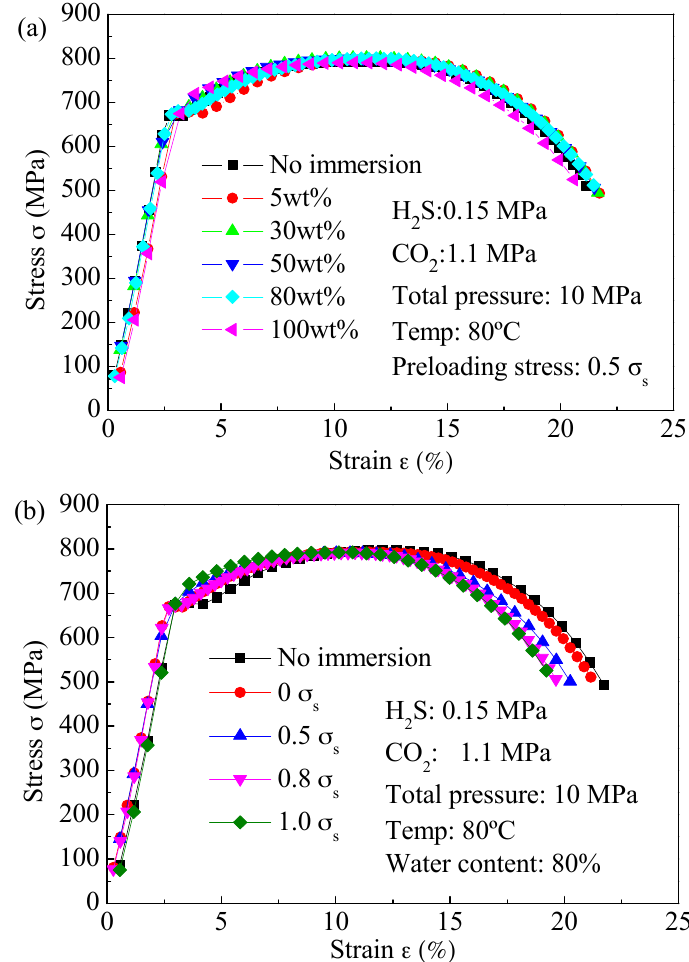
Figure 6. Dependence of stress–strain curve of L80 steel on: ( a ) water content; and ( b ) preloading stress after immersion in the test medium for 720 h. after immersion in the test medium for 720 h.